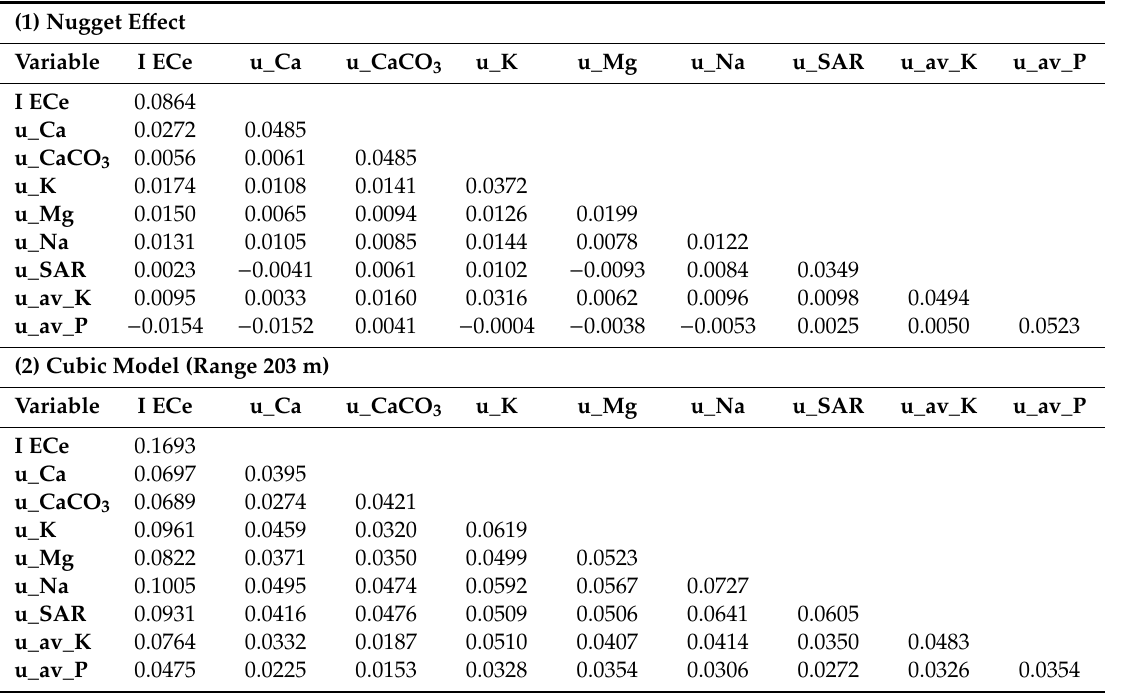
Table 3. Fitted sills of the linear model of co-regionalization relative to the di ff erent spatial structures. The symbol I stands for indicator whereas u stands for uniform